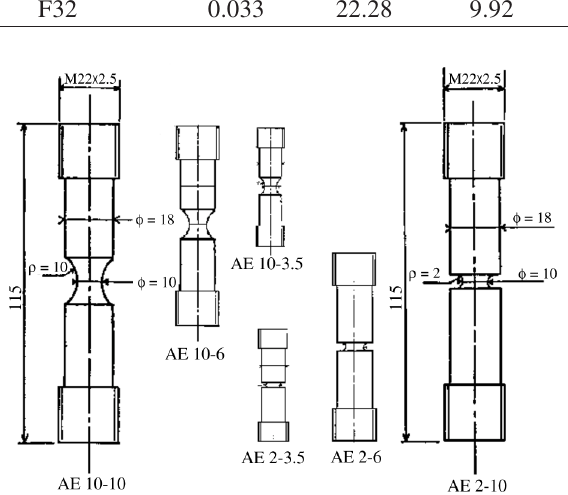
Figure1. Notch axisymmetric specimens